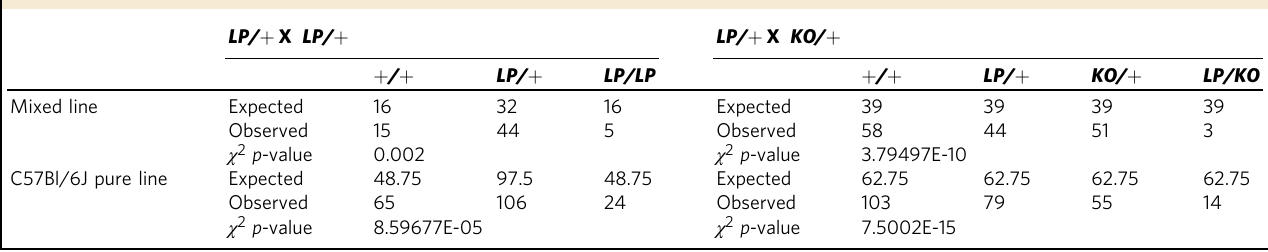
Table 1 Observed and expected number of offspring of various genotypes obtained from Brca2 LP/ + intercross and Brca2 LP/ + X Brca2 KO/ + cross.